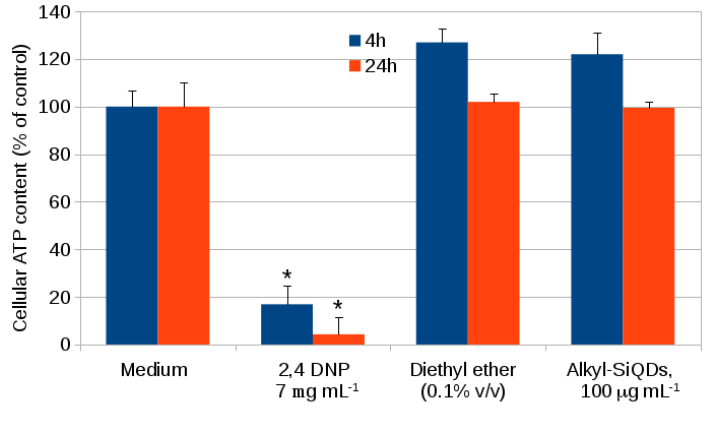
Figure 5. Cytotoxicity studied in CACO-2 after exposure to SiQDs for 4 h and 24 h using the 3-(4,5-dimethylthiazol-2-yl)-2,5-diphenyltetrazolium bromide (MTT) assay. Cell viability (% of control) is plotted as mean ± SD for n = 3 experiments. Significant effects ( p < 0.05) are marked with an asterisk *.